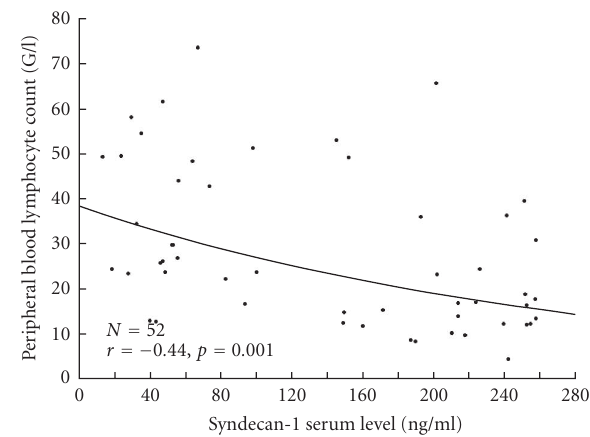
Figure 1: Relationship between Syndecan-1 serum level and pe- ripheral blond lymphocyte count in 52 untreated B -CLL patients (the exponential curve is a supportive